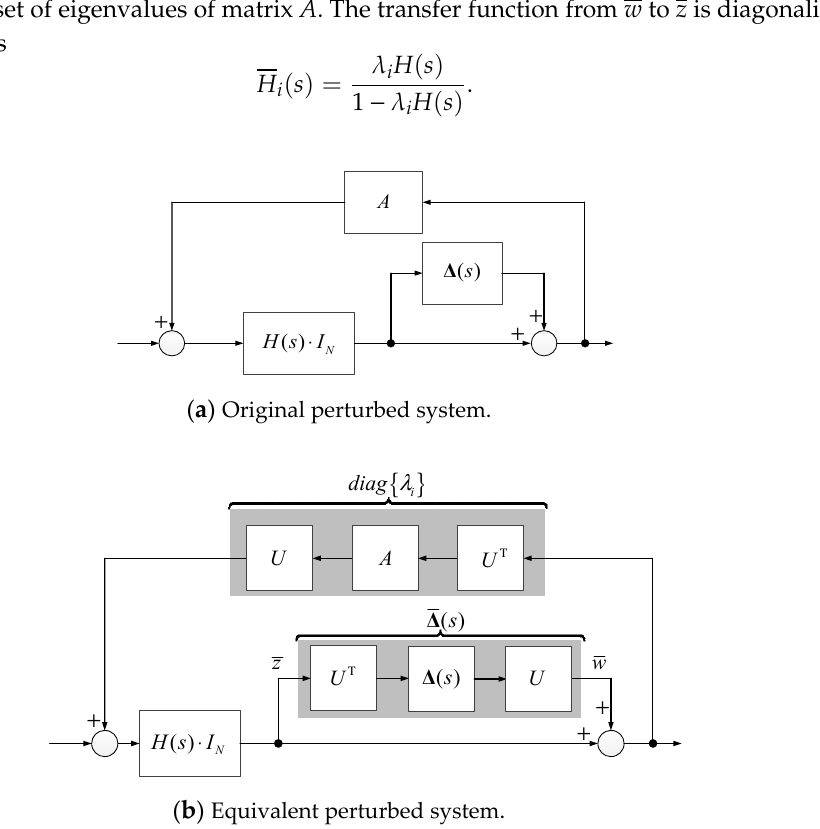
Figure 11. Vehicle control system as a multi-agent-system with perturbation.